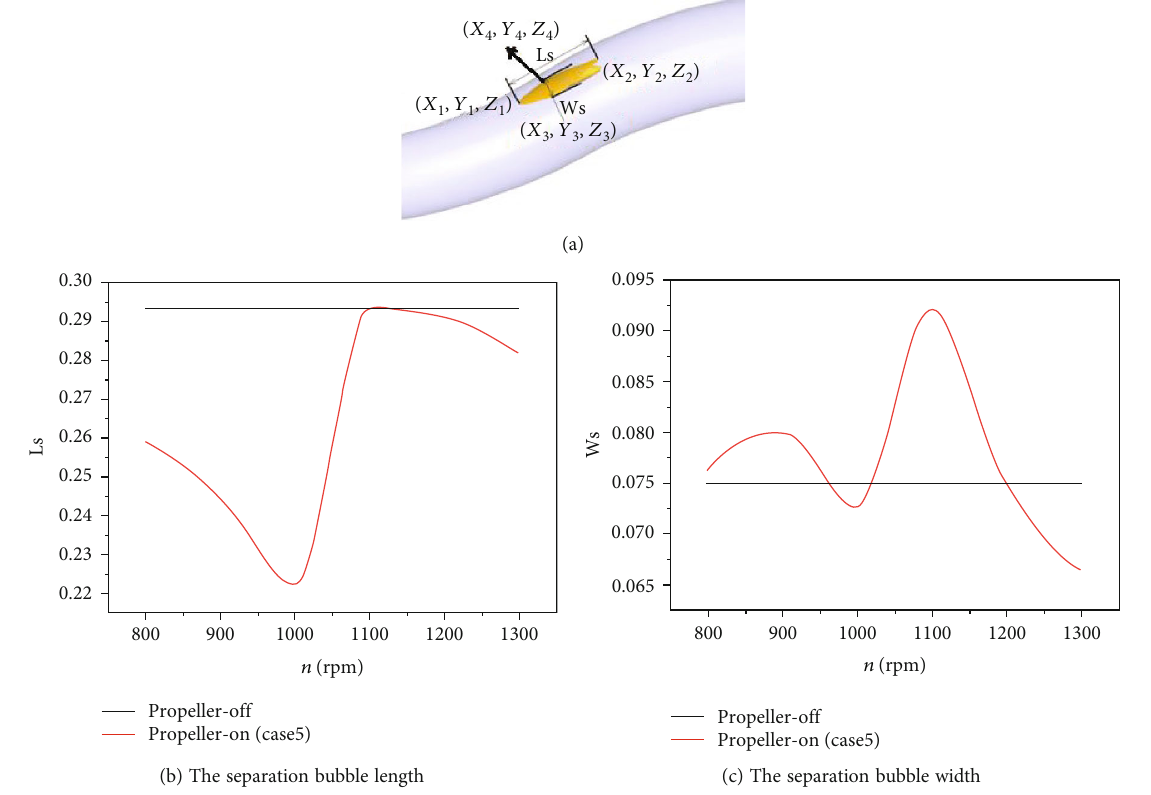
Figure 11: Length and width of separation